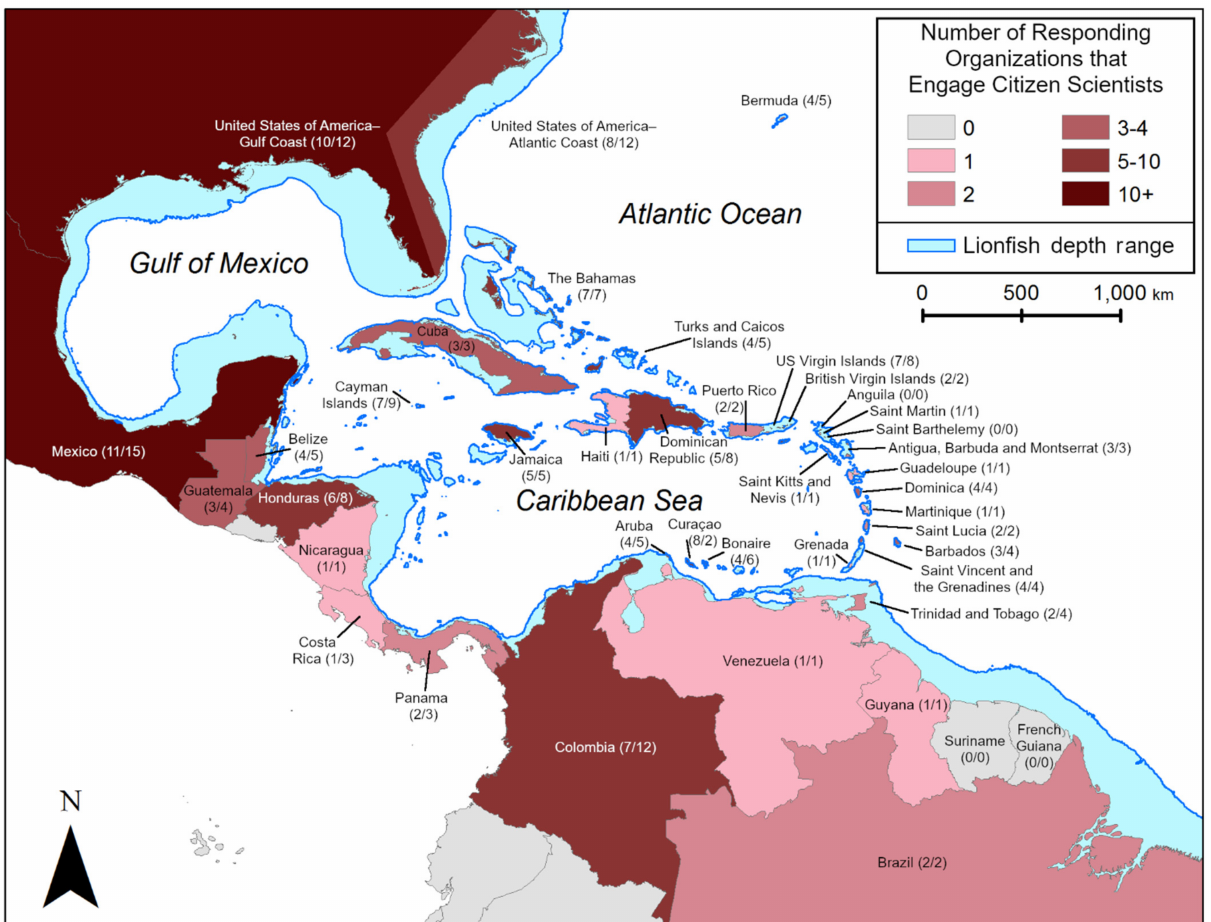
Figure 1. Map showing the lionfish invaded range and information about responding organizations. The number immedi- ately after each location name is the number of organizations that responded to the survey, have worked in that location, and engage citizen scientists. The number after the slash (/) is the number of organizations total that have worked in each location and responded to the survey. Darker colors represent countries with more organizations that engage citizen scientists and lighter colors represent fewer organizations. Gray represents locations with no response. The lionfish depth range is defined as the ~300 m contour throughout the invaded range (North Carolina through Brazil). Lionfish are capable of occupying a range of habitats from 0.5 m to deeper than 300 m [34], and lionfish have been detected across the extent of this map as re- ported to the USGS Nonindigenous Aquatic Species database (https://nas.er.usgs.gov/viewer/omap.aspx?SpeciesID=963, accessed on 1 July